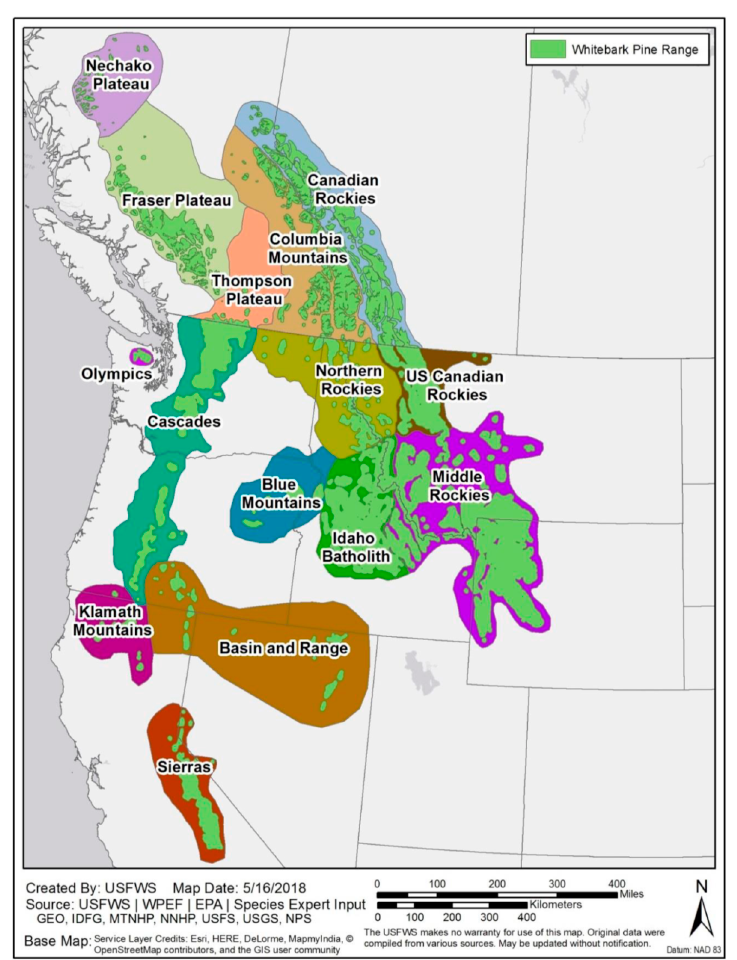
Figure 2. The regions used by the US Fish and Wildlife Service for evaluation whitebark pine for conservation. These regions are used in this paper.